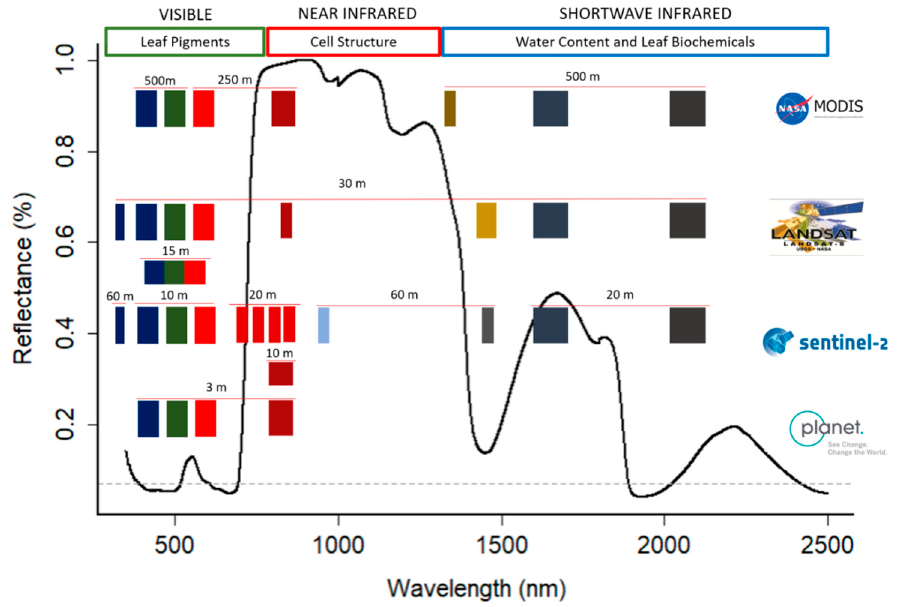
Figure 2. Crop reflectance spectral features, and representation of MODIS (Moderate Resolution Imaging Spectroradiometer), Landsat-8, Sentinel-2, and Planet multispectral bands and spatial